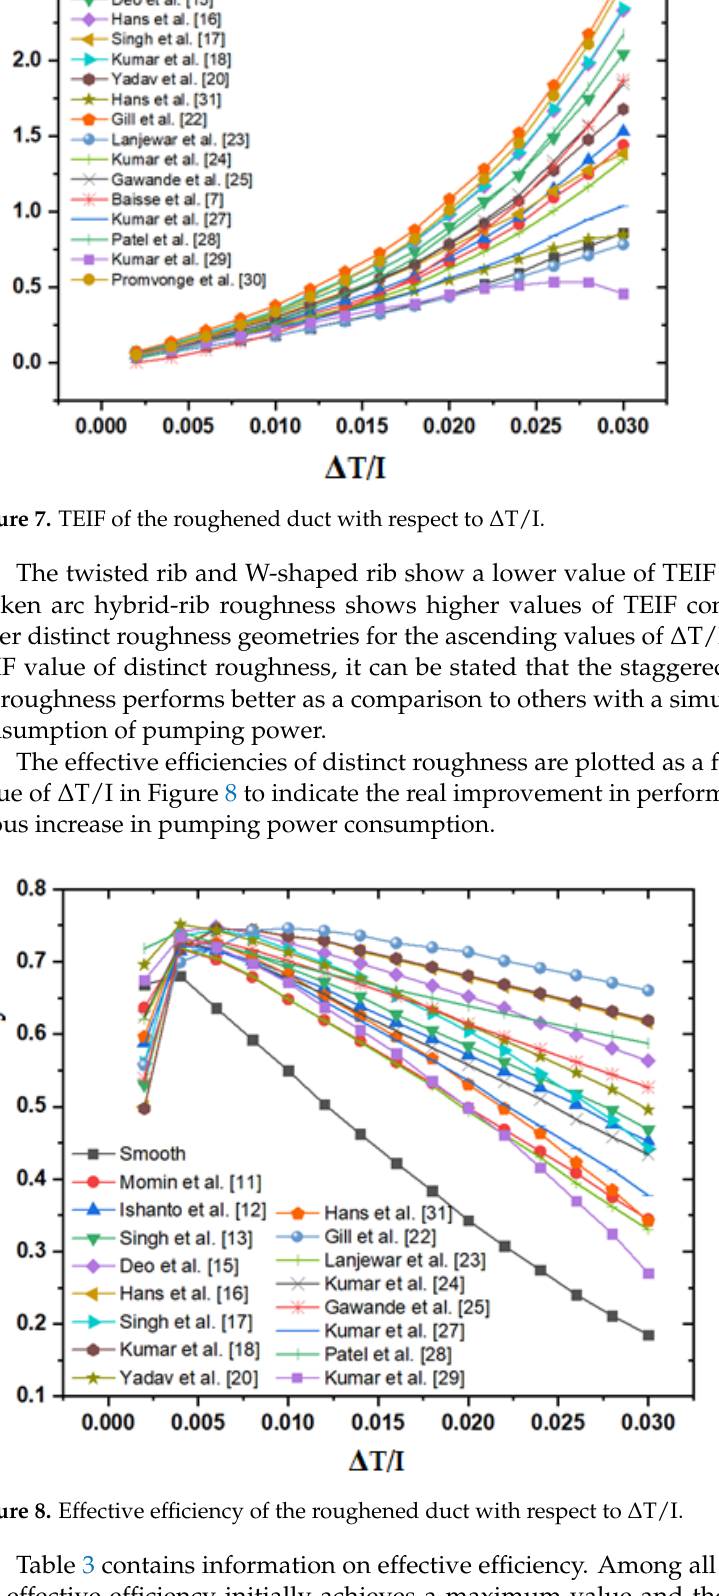
Figure 8. Effective efficiency of the roughened duct with respect to Δ T/I.